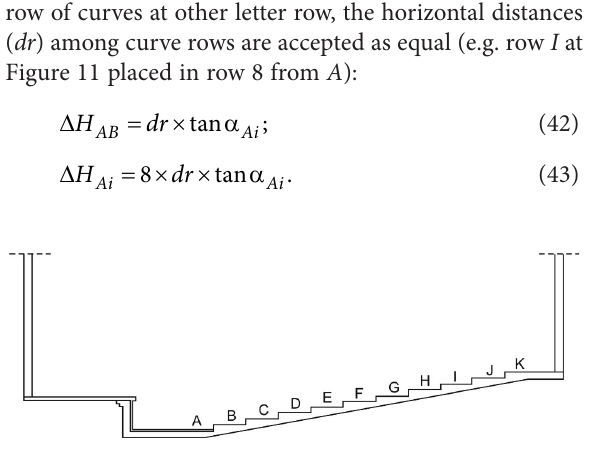
Figure 11. The profile of inside of auditorium in indoor